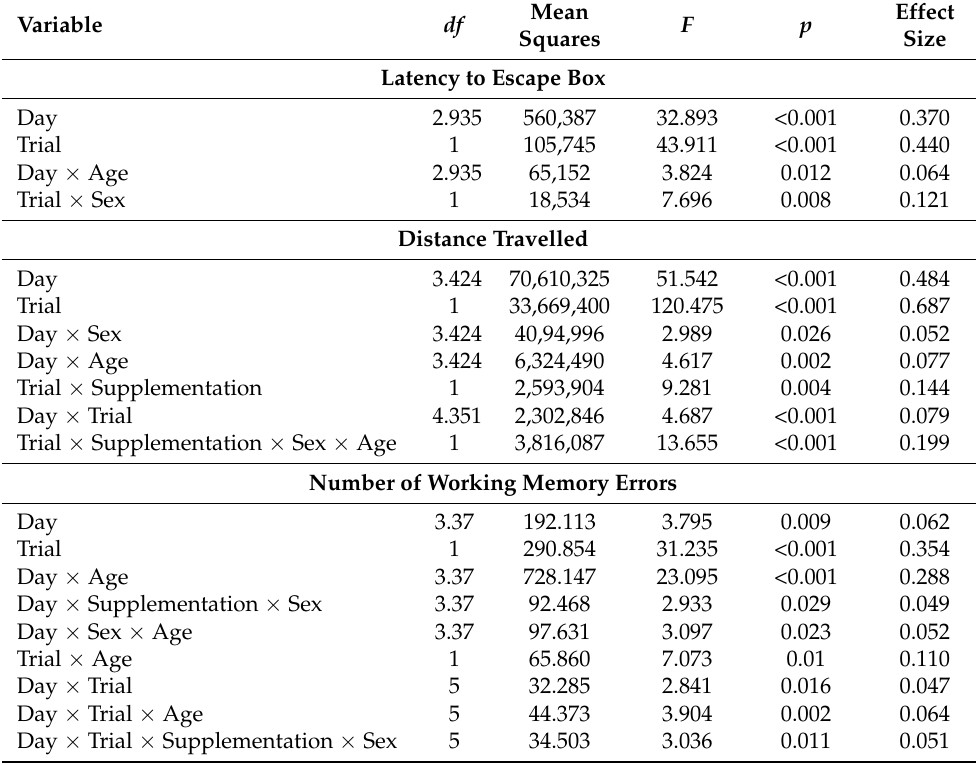
Table 1. ANOVA Summary Table for the Acquisition